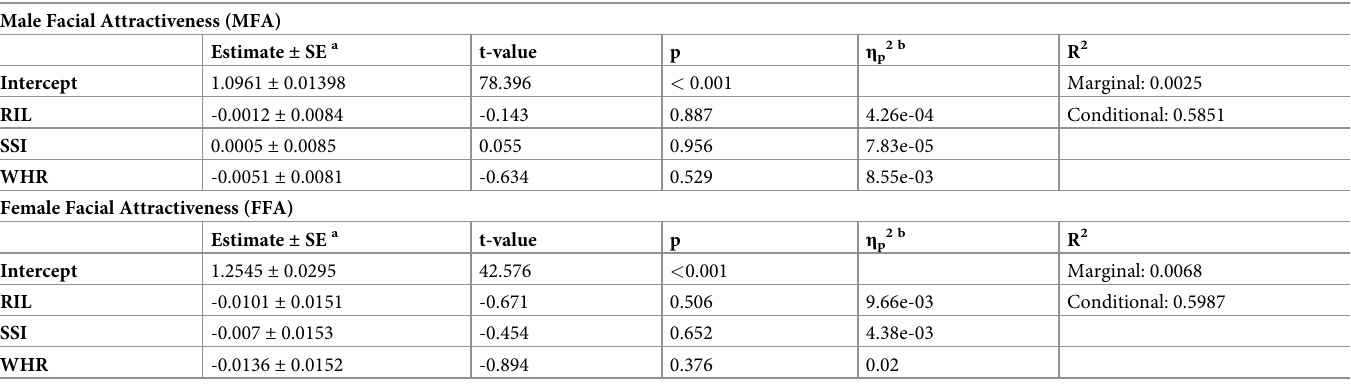
Table 2. LMM results explaining attractiveness variance in the MFA and FFA